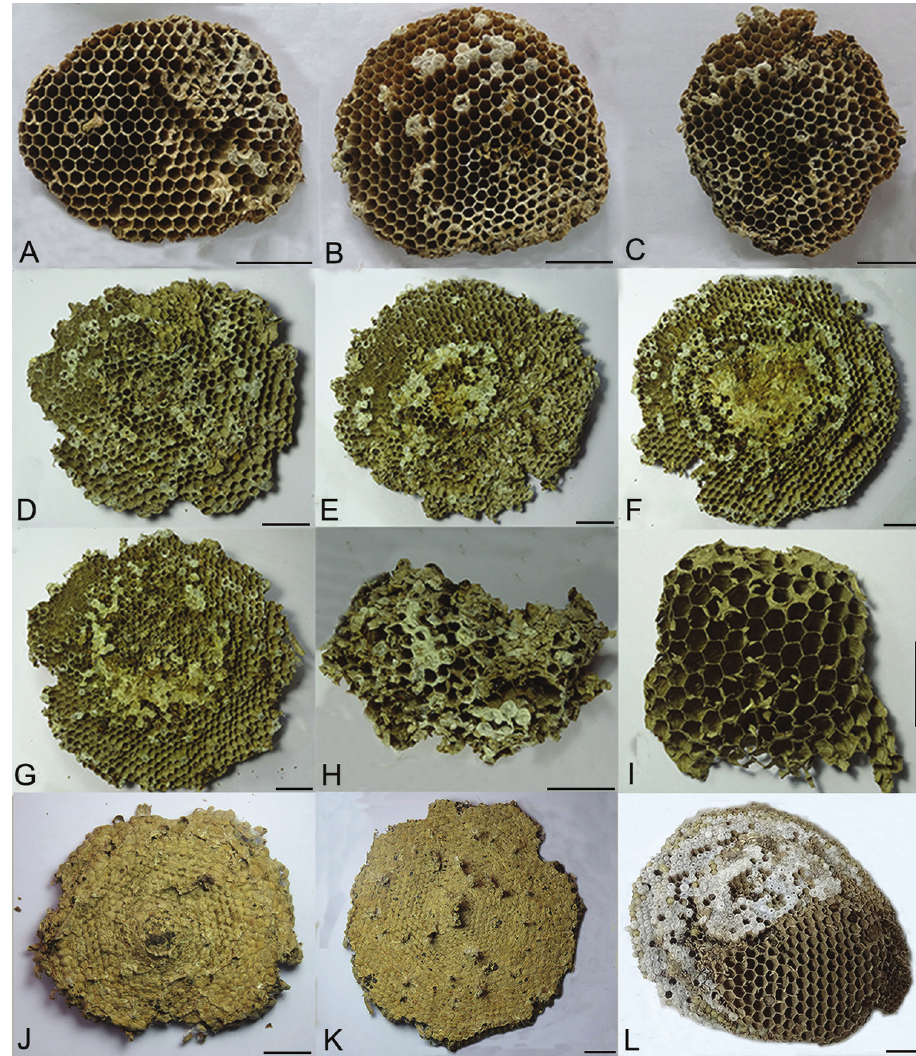
Figure 2. Vespula structor (Smith). A–C Three layers of nest (from Xunyangba) D–I Six layers of nest (from Baoji) J one central buttressed sheet and many thinner auxiliary pedicels on the first comb K many thinner auxiliary pedicels on the third comb L different diameters of cell, vertical view. Scale bar: 2 cm. devoid of immature stages; obviously only large cells with the diameter (between op- posite sides) about 7.0 mm were present (Figure 2L). The other combs having a diam- eter (between opposite sides) of approx. 4.5 mm. Three stages (egg, larvae, pupa) were visible according to the cyclic arrangement of the successive cocoons of the preliminary five layers (Figure 1F). Most cells were capped by silken cocoons and these capped cells were 1.0–1.3 cm high. Cocoon caps of the third and fourth combs are slightly larger than those of the upper combs, protruding about 0.5 cm beyond the cell